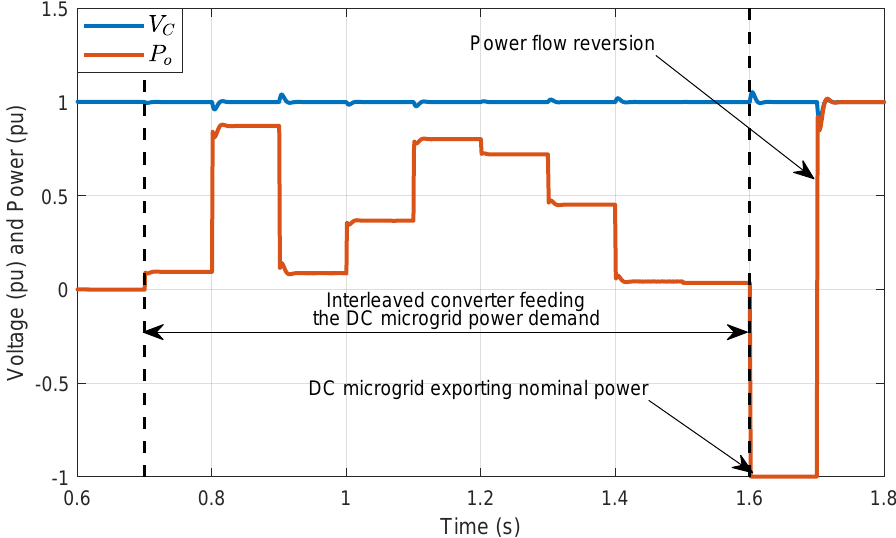
Figure 15. DC microgrid operating with bidirectional power flow and with different levels of load and generation connection resulting in different power steps imposed on the DC microgrid. In this figure, the output voltage ( v c ) and the output power ( P o ) are